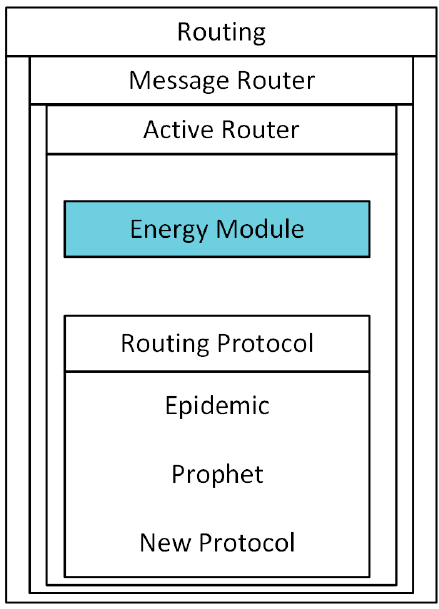
Figure 2. Energy module implementation in the ONE simulator.